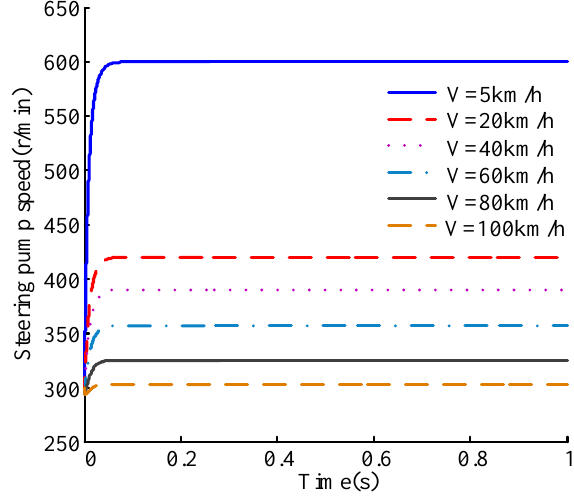
Figure 17. Graph of steering pump speed at different speeds.